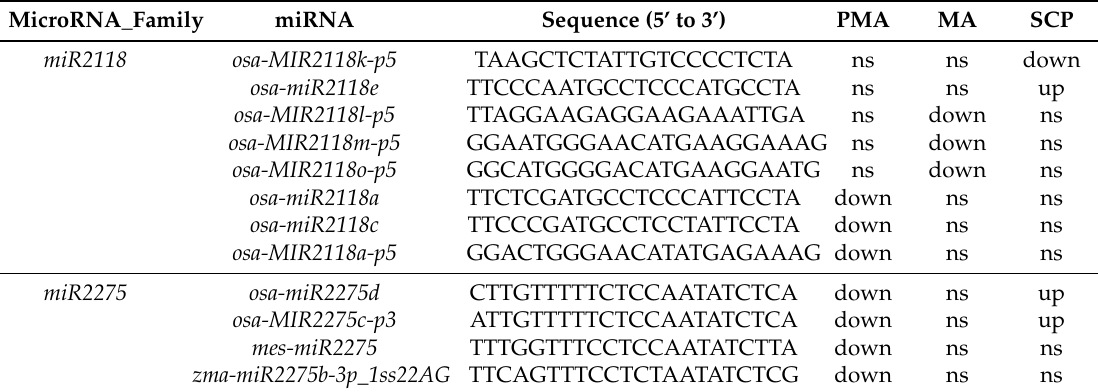
Table 3. The regulation of miR2118 and miR2275 families in autotetraploid